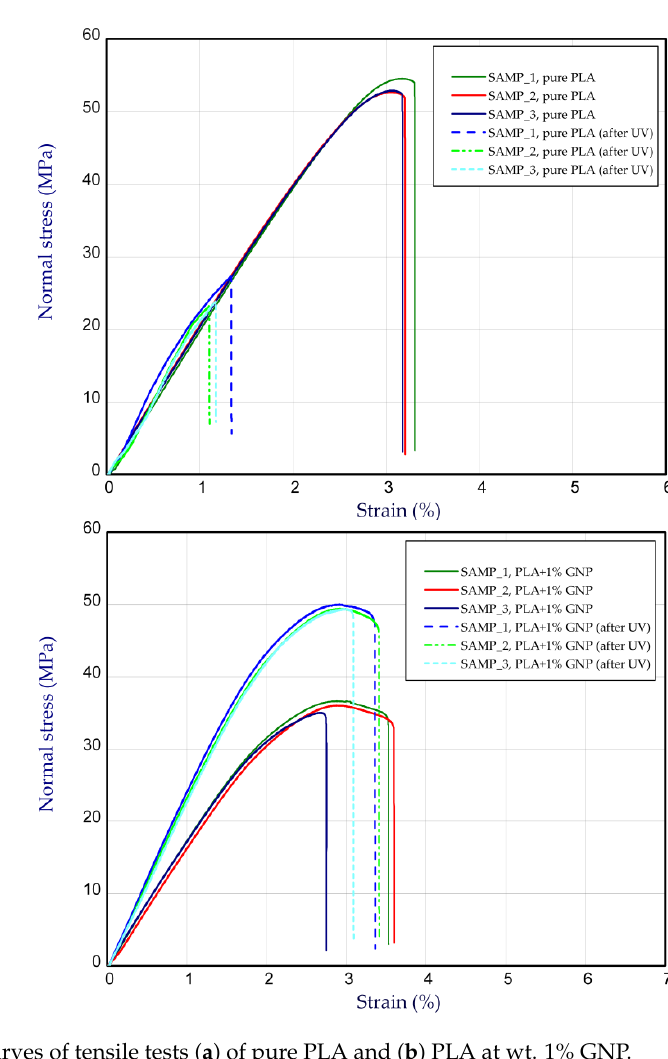
Figure 4. The curves of tensile tests ( a ) of pure PLA and ( b ) PLA at wt. 1% GNP.